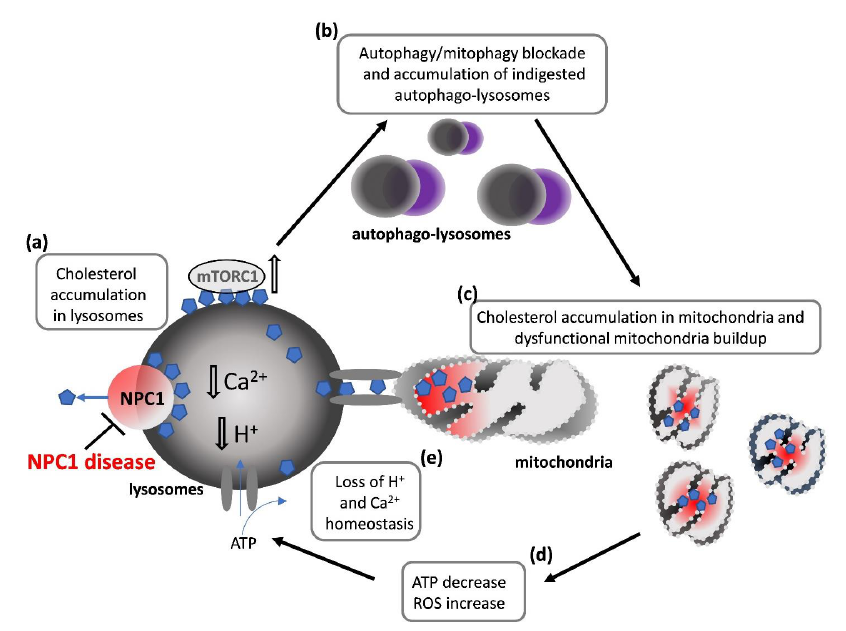
Figure 2. Cellular events involved in NPC1 disease: ( a ) cholesterol accumulation in lysosomes due to the loss of function of the cholesterol (ch) transporter NPC1; ( b ) autophagy/mitophagy blockade and accumulation of indigested autophago-lysosomes due to lysosomal accumulation of ch, ch-induced hyperactivation of the anti-autophagy complex mTORC1; ( c ) accumulation of dysfunctional mitochondria due to accumulation of ch in mitochondria and mitophagy blockade; ( d ) ATP production decrease and ROS increase by dysfunctional mitochondria; ( e ) loss of lysosomal ionic homeostasis. Blue pentagons: cholesterol.